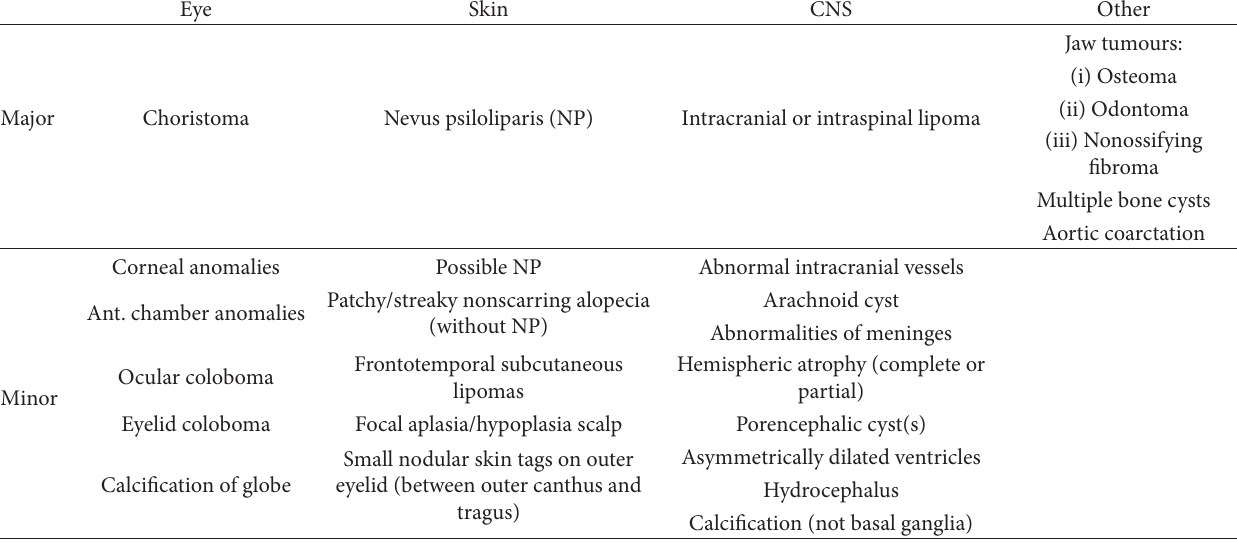
Table 1: Diagnostic criteria (adapted from Moog et